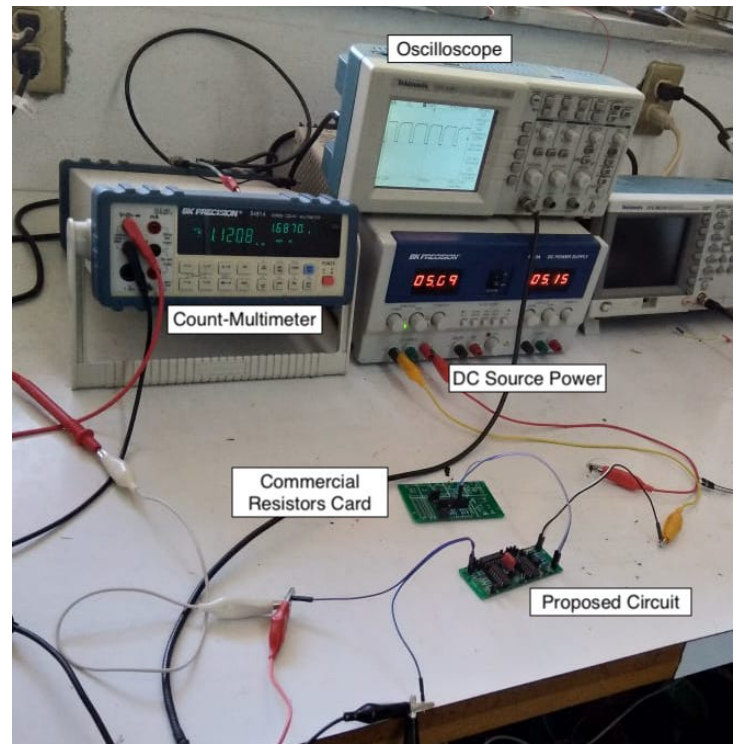
Figure 8. Experimental